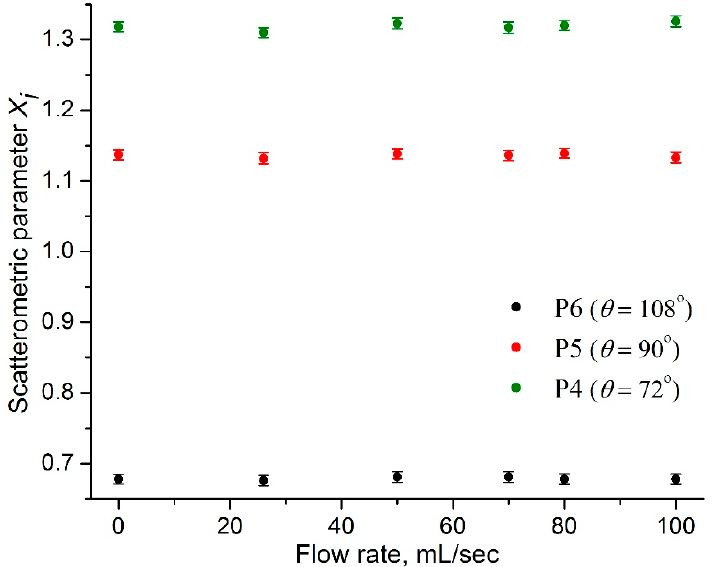
Figure 6. Dependence of the scatterometric parameter X i on the milk flow rate for milk with a fat percentage 3.2% at a temperature of 20 °C.